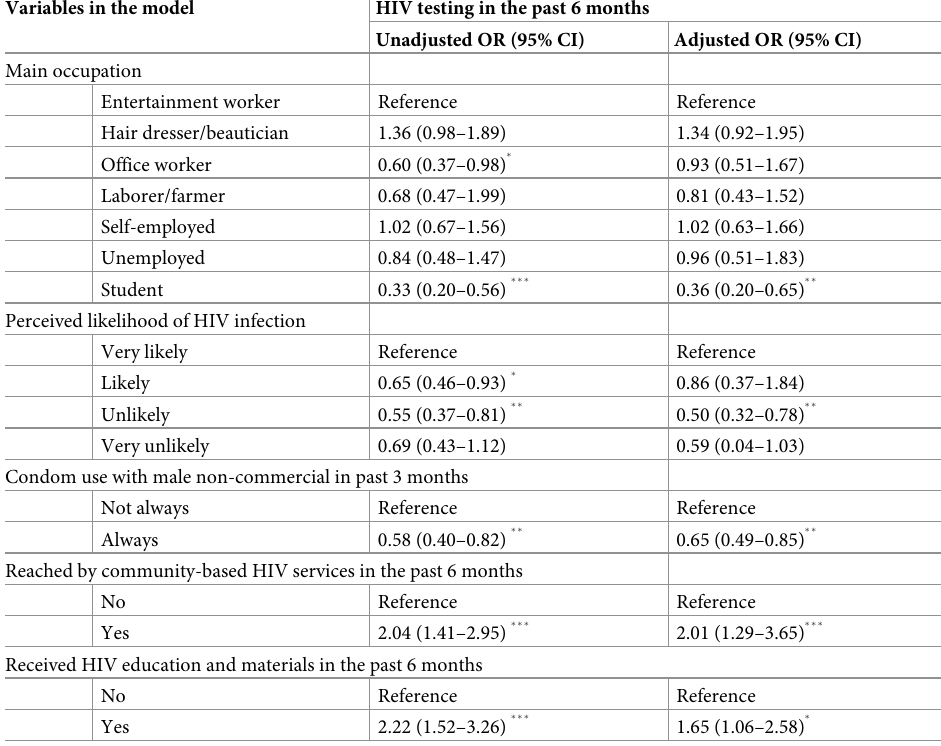
Table 4. Factors associated with recent HIV testing among transgender women in a multiple logistic regression model ( n =